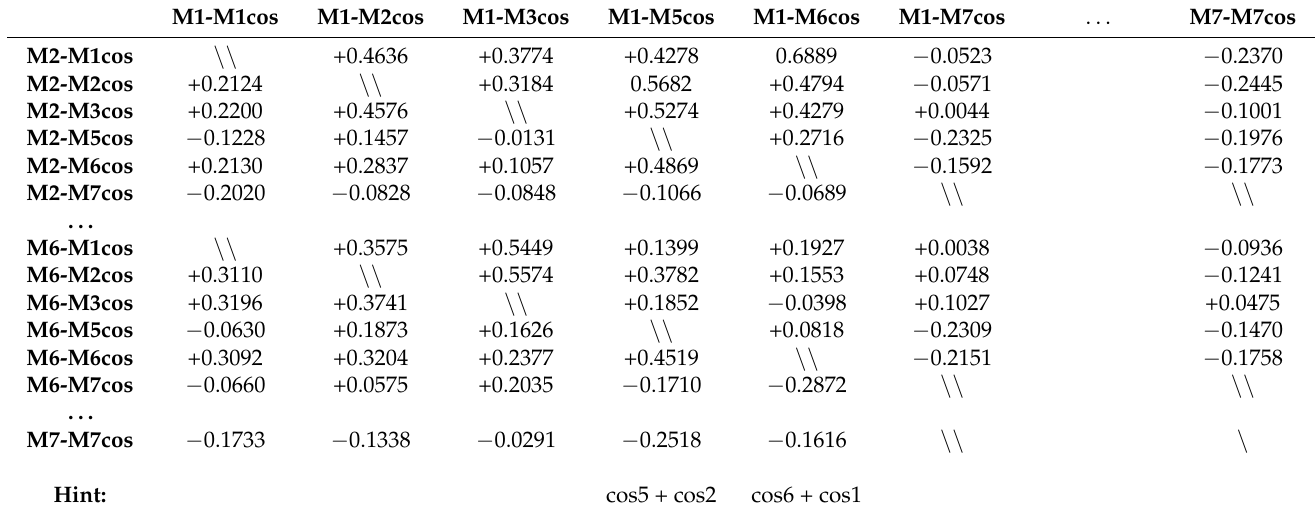
Table 1. An extract of the pair-to-pair correlation